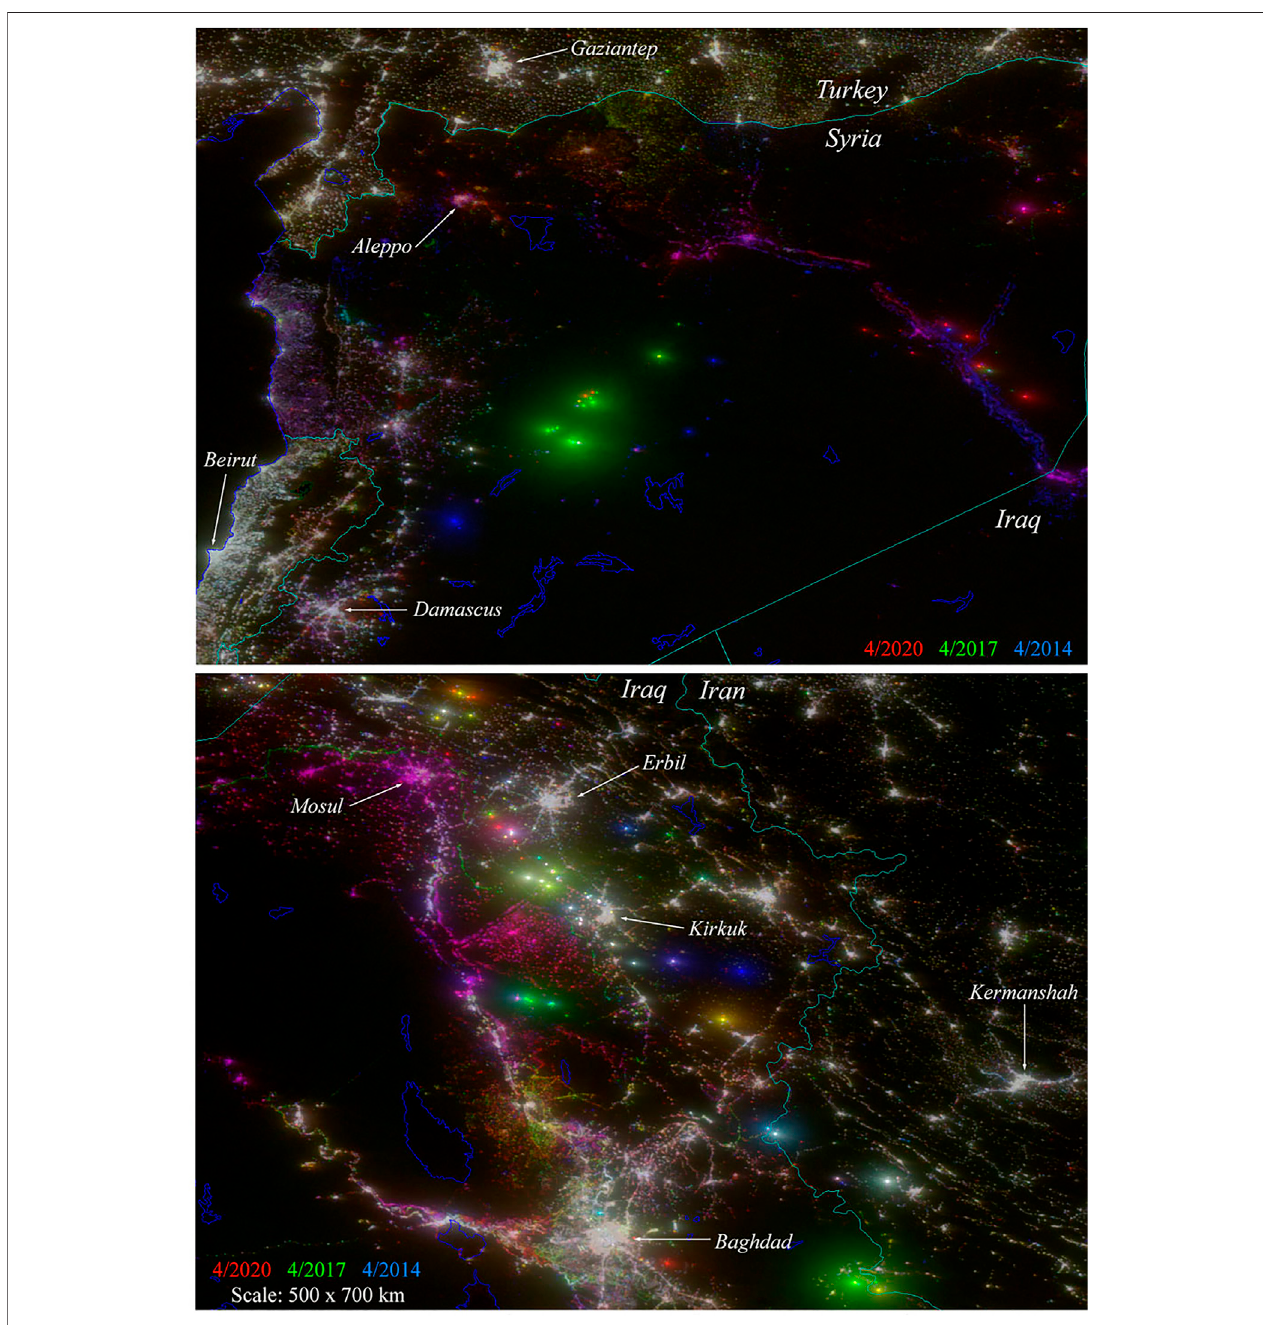
FIGURE 13 | Interannual variability of anthropogenic night light associated with con fl ict. Stable lights appear shades of gray. Color implies change. Bright isolated lights with halos are gas fl ares. Large area changes of smaller lights likely indicate changes related to power outages at the time of VIIRS ′ overpass.